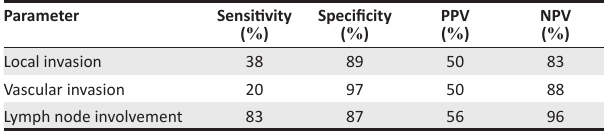
PPV, positive predictive value; NPV, negative predictive